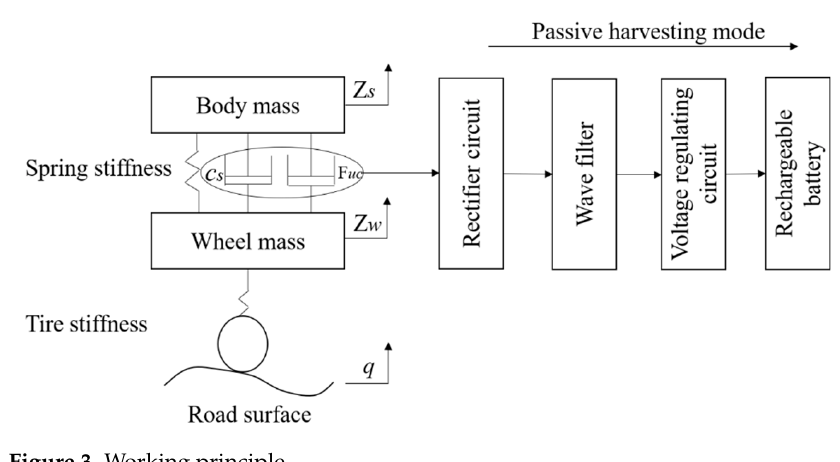
Figure 3. Working principle.